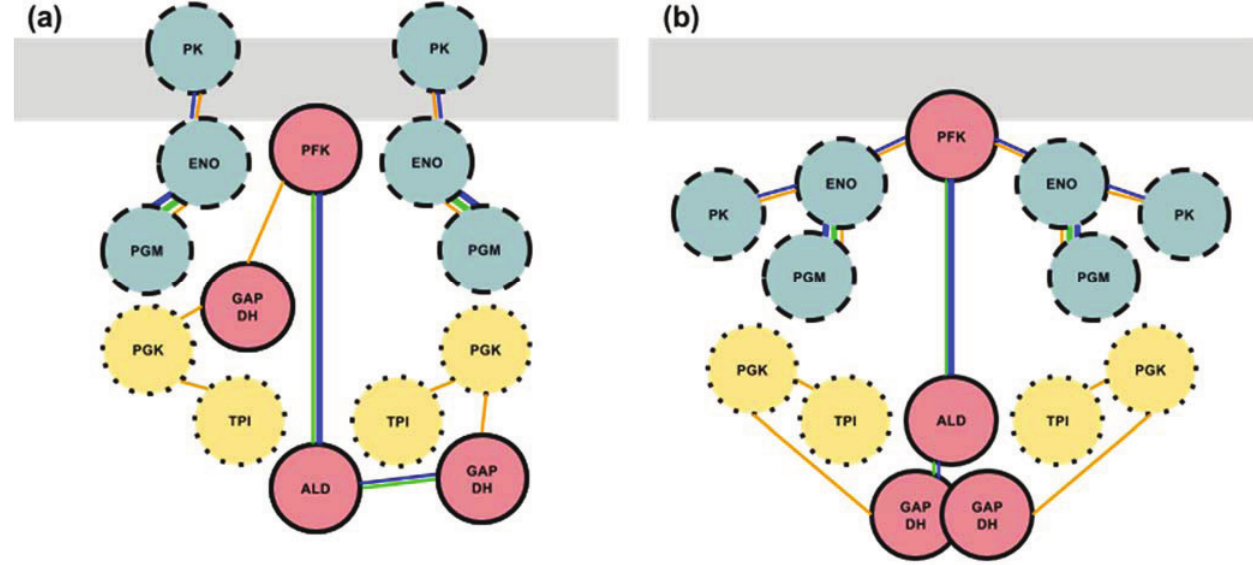
Figure 3. Two possibilities for how the three subcomplexes could form a full, active glycolytic complex. The members of the triose pathway are doubled in accordance with previous stoichiometric experimental studies [23]. Each circle represents an entire enzyme ( i.e. , all subunits). The grey bar represents a thin filament composed of F-actin, troponin and tropomyosin. The three subcomplexes are designated by their appropriate borders and colors (see Figure 2). Lines connecting the enzymes indicate a specific interaction as described in Figure 2. Physical contact of GAPDH represents